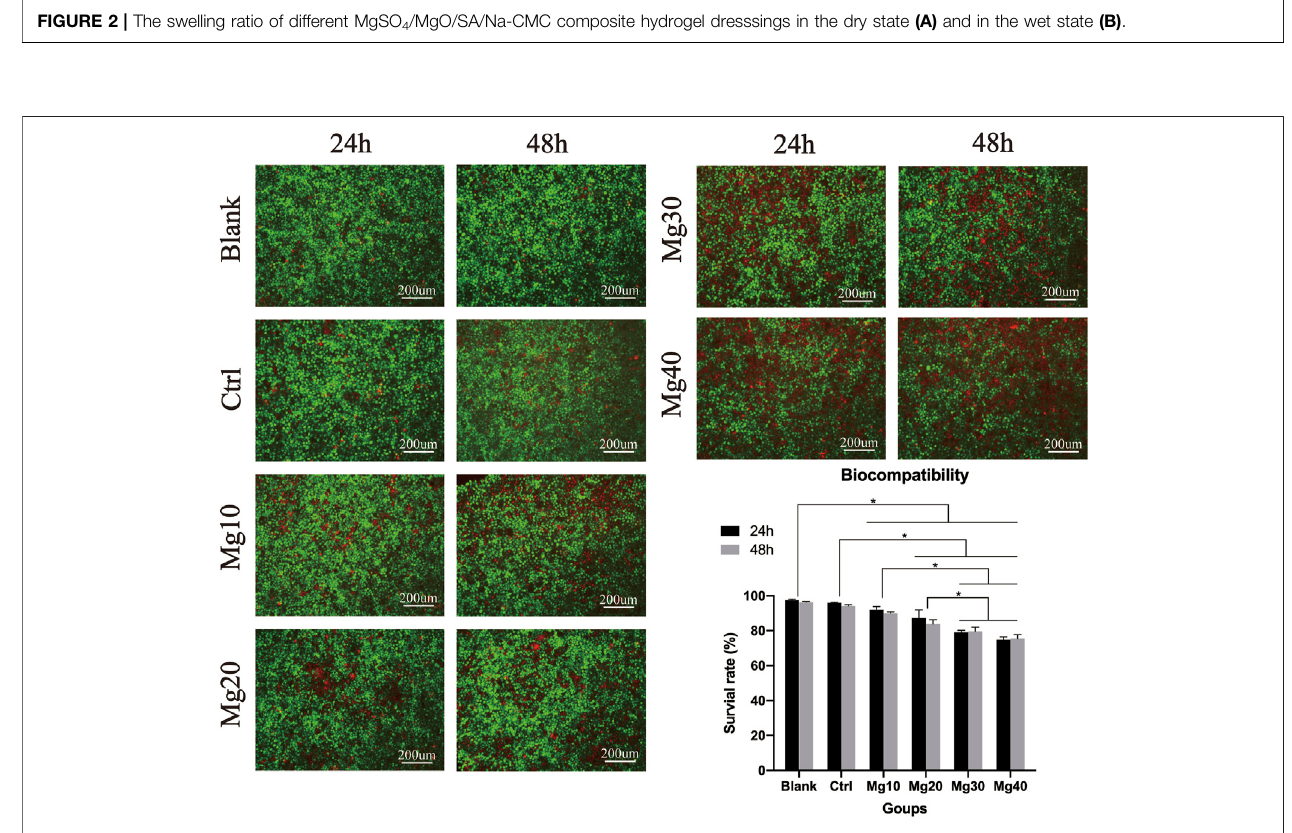
FIGURE 3 | Biocompatibility. P ≤ 0.05 was considered statistically signi fi cant (*).